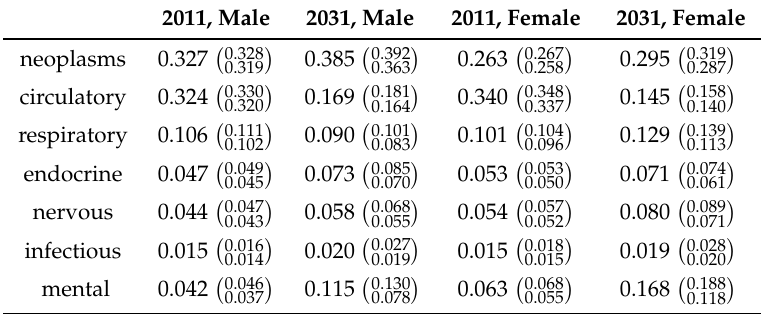
quantiles are given in